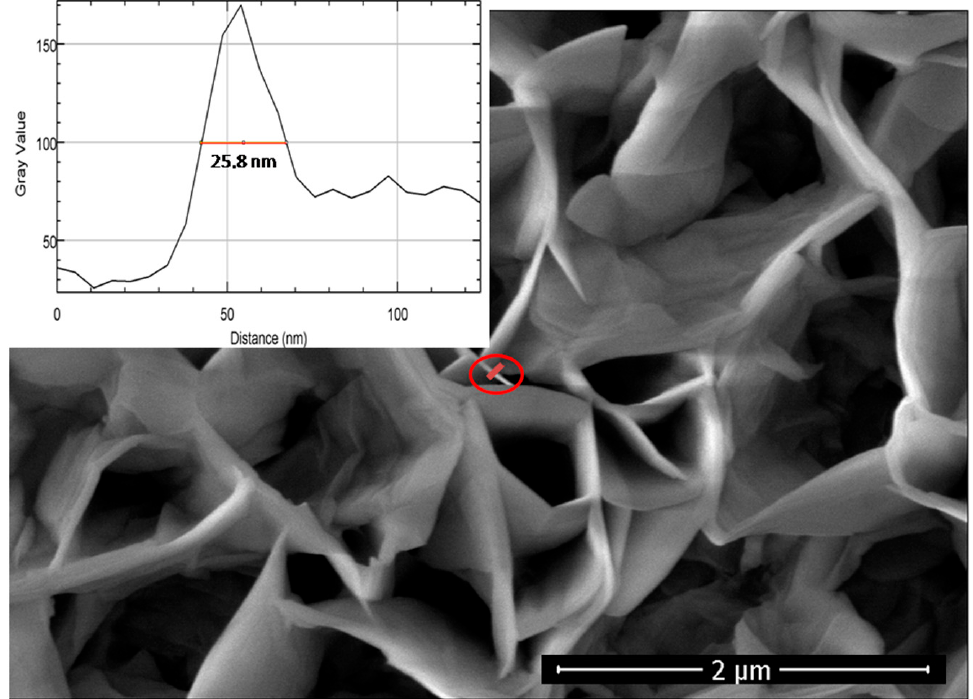
Figure 3. Plane-view SEM image of ZnO nanowalls grown for 60 min. The inset reports the intensity of the pixels in grey scale along the red line drawn across the wall (into red circle) as a function of the distance (nm).